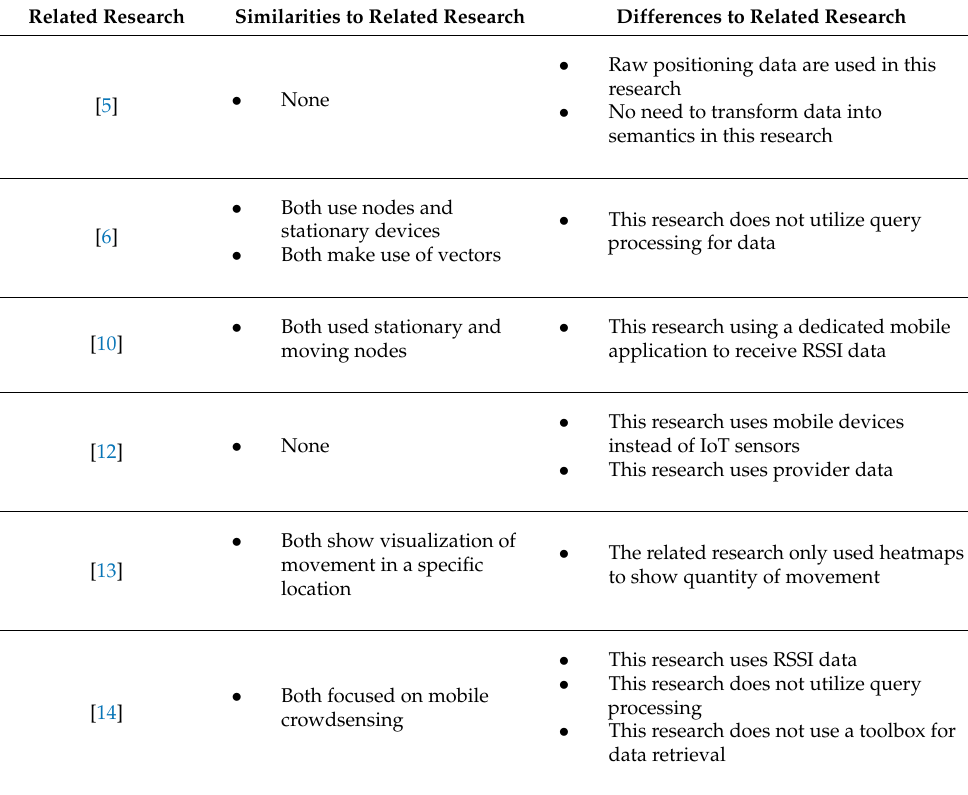
Table 1. Similarities to and differences from related